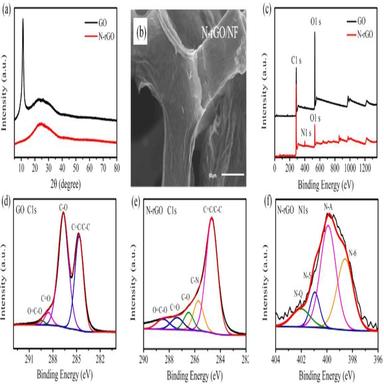
(a) XRD patterns of the GO and N-rGO, (b) SEM image of the N-rGO,(c) The XPS survey spectrum of the GO and N-rGO, (d) High resolution C1s XPS spectra of GO, (e) High resolution C1s XPS spectra of N-rGO, (f) High resolution N1s XPS spectra of N-rGO.